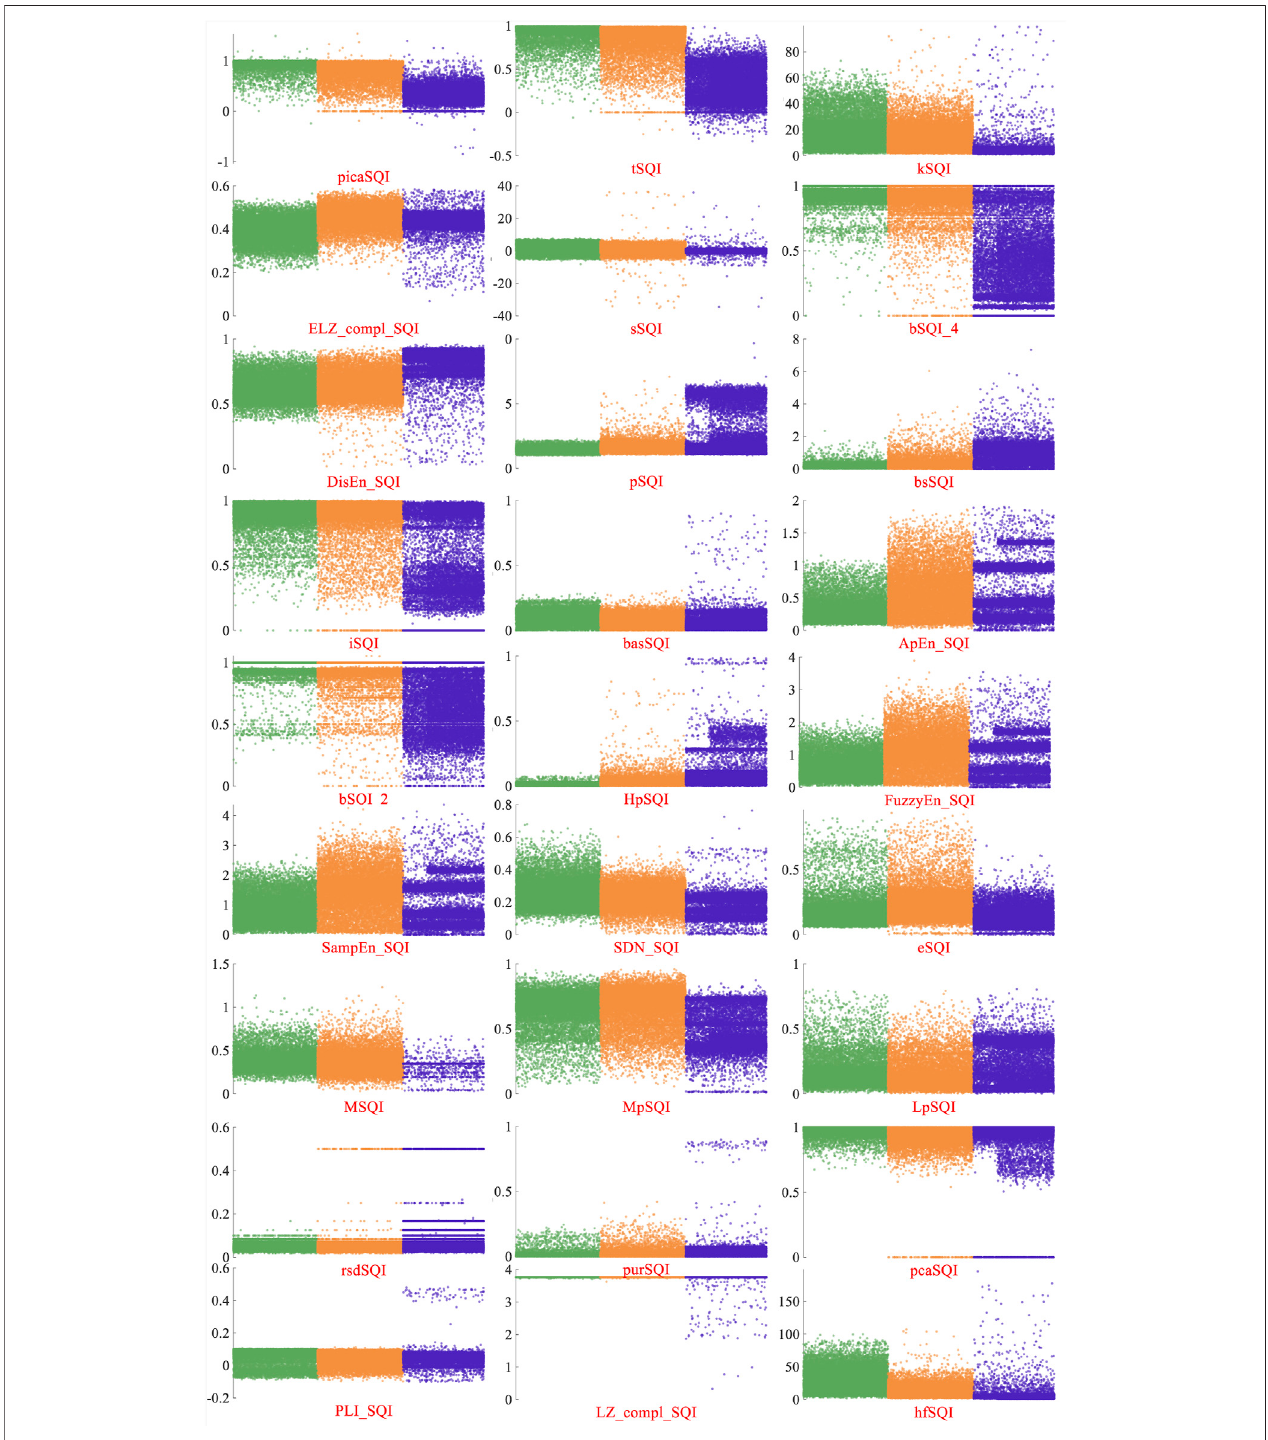
FIGURE 7 | Distribution of 27 SQIs on the A/B/C quality levels signals. Green, orange, and blue dots represent class A/B/C signals, respectively.